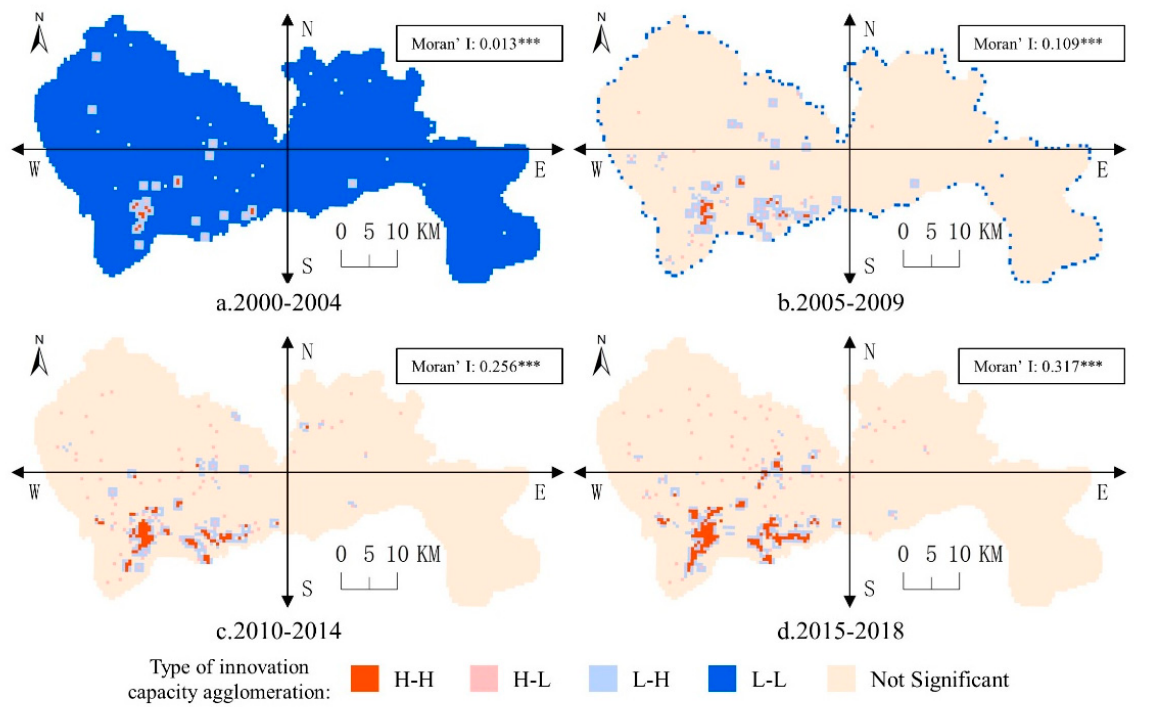
Figure 3. Evolution of the innovation agglomeration pattern of the tertiary industry in Shenzhen from 2000 to 2018.